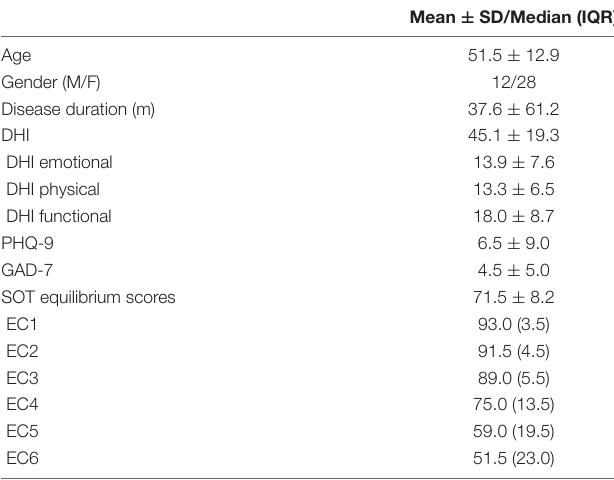
TABLE 1 | Demographic and clinical characteristics of patients with otogenic vertigo.